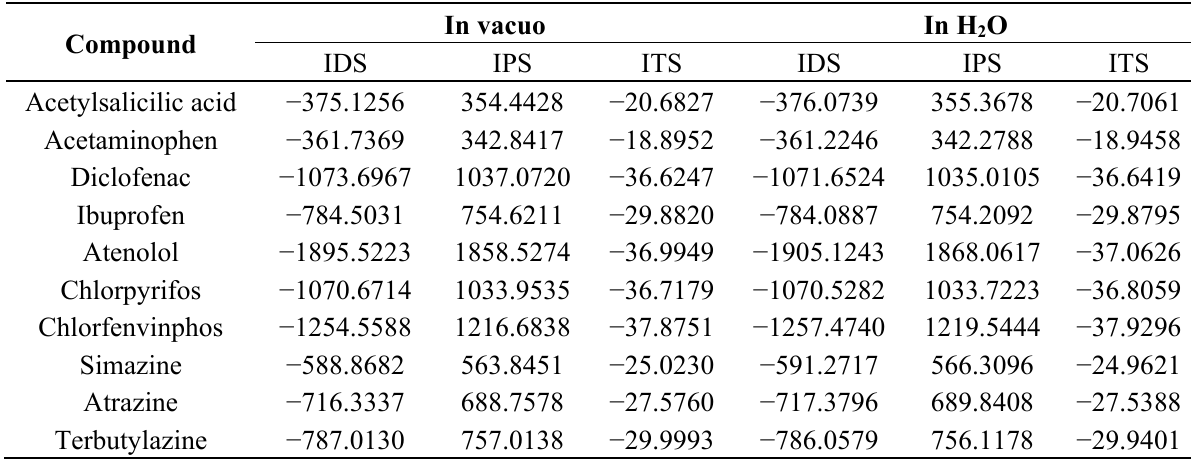
Table 2. Isotropic diamagnetic susceptibility (IDS), isotropic paramagnetic susceptibility (IPS) and isotropic total susceptibility (ITS) a in